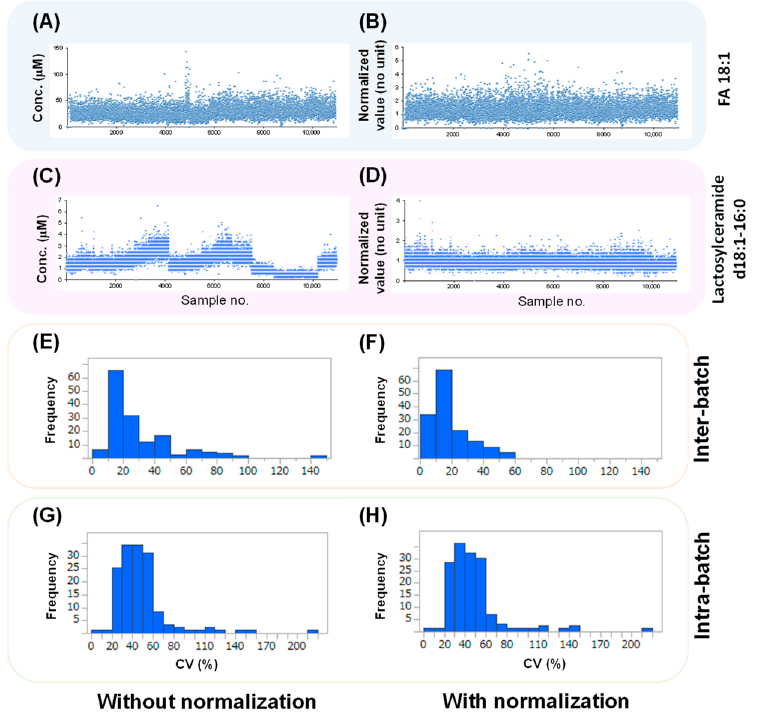
Figure 4. Comparison of the quantified values of the two metabolites without and with normalization. ( A , B ) The FA 18:1 data. ( C , D ) The lactosylceramide d18:1-16:0 data. ( E , F ) Histograms of the interbatch data. ( G , H ) Histograms of the intrabatch data. ( E – H ) The X- and Y-axes indicate the CV values and frequencies, respectively, of 147 metabolites.